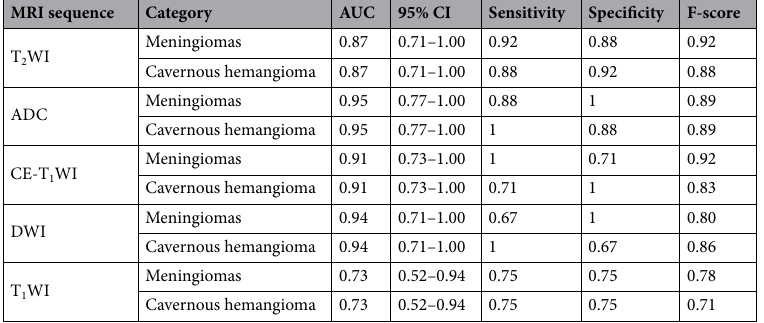
Table 5. Performance of SVM classifier radiomics models in differentiating parasellar cavernous hemangiomas from meningiomas in the validation set. MRI magnetic resonance imaging, T 1 WI T 1 -weighted